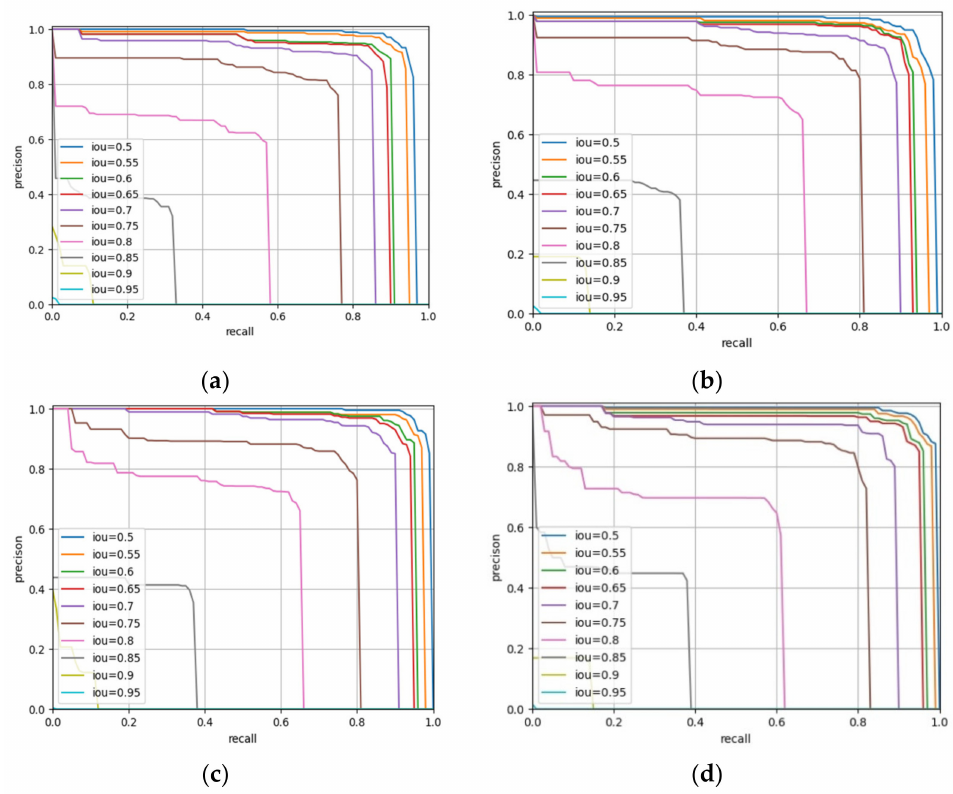
Figure 14. The PR curves of the experiment of using NMS to eliminate the detection frames with sizes that did not meet the range: ( a ) the PR curve of the experiment performed without eliminating the non-conforming detection frame by NMS, with the anchor frame foundation size of 8 and proportions of 0.5, 1, 2; ( b ) the PR curve of the experiment performed eliminating the non-conforming detection frames by NMS, with the anchor frame foundation size of 8 and proportions of 0.5, 1, 2; ( c ) the PR curve of the experiment performed without eliminating the non-conforming detection frame by NMS, with the anchor frame foundation size of 4 and proportions of 0.75, 1, 1.35; ( d ) the PR curve of the experiment performed eliminating the non-conforming detection frames by NMS, with the anchor frame foundation size of 4 and proportions of 0.75, 1, 1.35. Table 3. Test results before and after using NMS to eliminate the detection frames that did not fall within the scope when IoU was